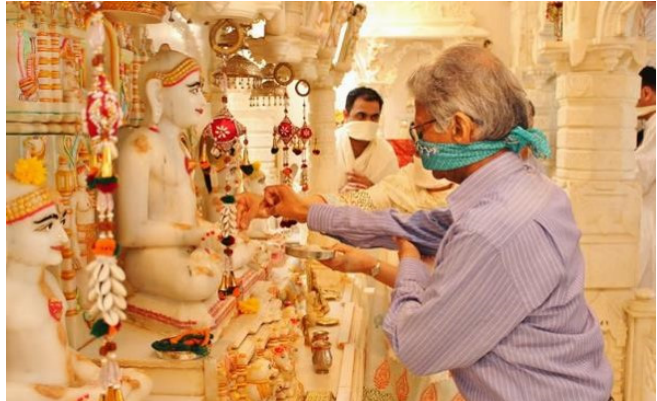
Figure 1. Ter ā panth ī sama ṇ ī s wearing the muhpatt ī during an evening pratikrama ṇ a ceremony. Lad- nun, December 2015. Photo by the author.